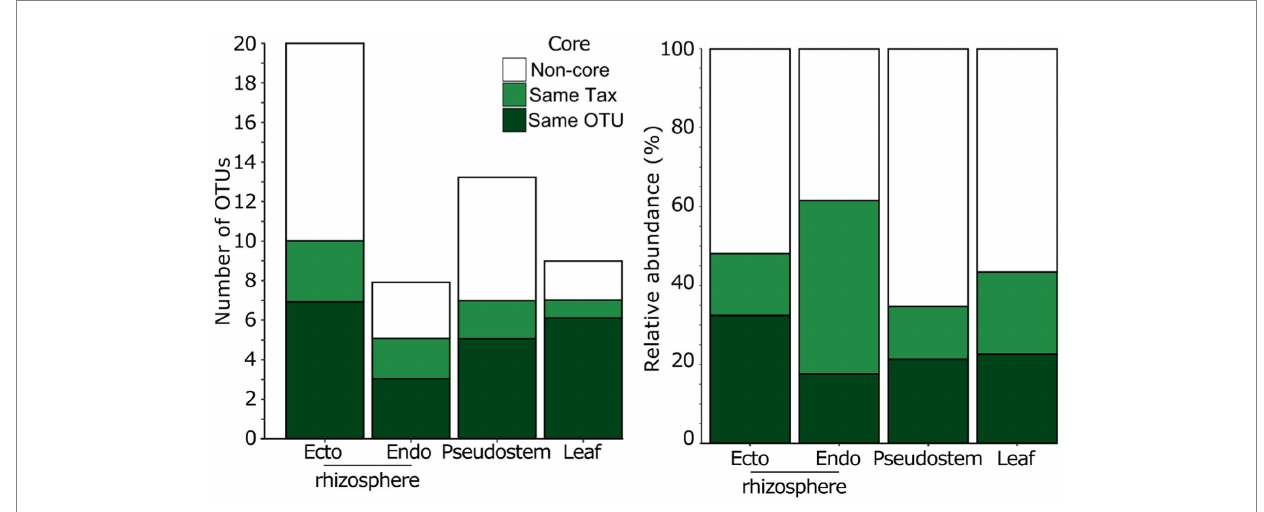
FIGURE 4 The number of abundant and prevalent OTUs from the field experiment and the relative abundance of fungi that were defined as core or non-core in each plant compartment from 52 field grown Musa spp.